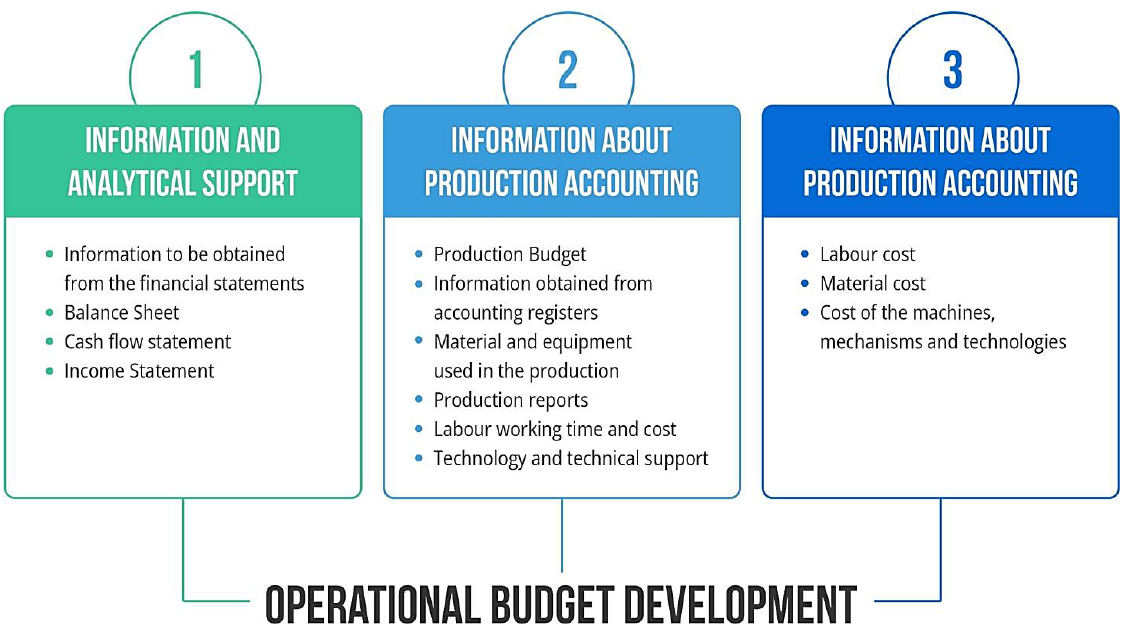
Figure 4. Model for improving the efficiency of budgeting at industrial